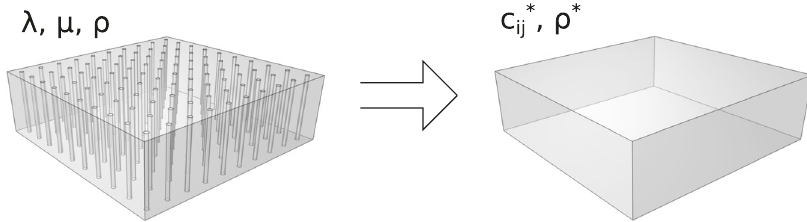
Fig. 1 Schematic of the process of homogenization of a holey phononic crystal plate. The real holey material with an isotropic elastic matrix material (parameters λ , μ , ρ ) will be considered as a continuous homogenized but anisotropic metasolid with effective elastic parameters c (cid:1) ij , ρ